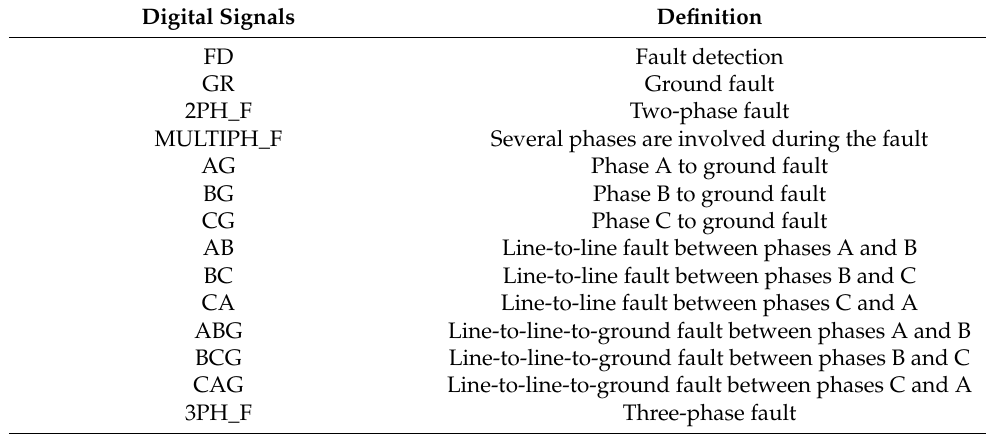
Figure 15. Faulted phase selector when AB fault is applied and K - factor = 3.5 using Strategy B. Table 3. Digital signals